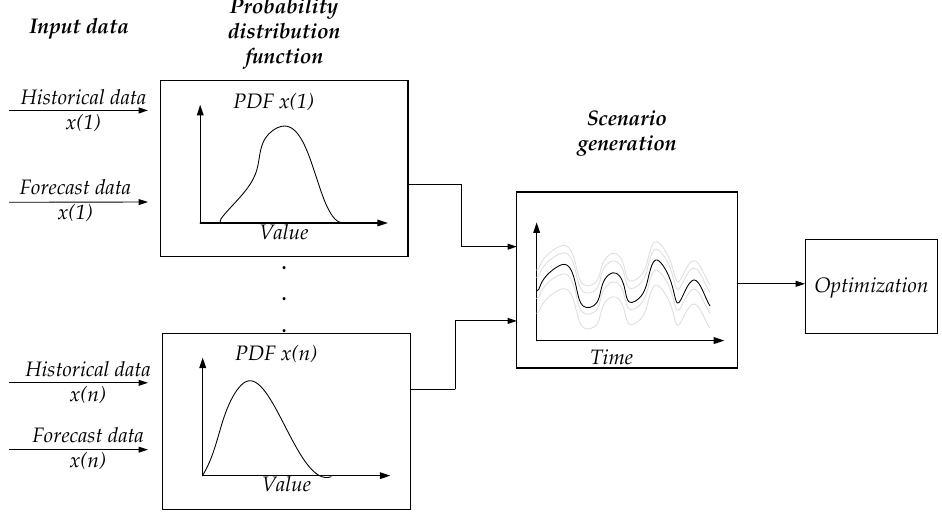
Figure 7. Flow diagram of the Monte Carlo simulation in